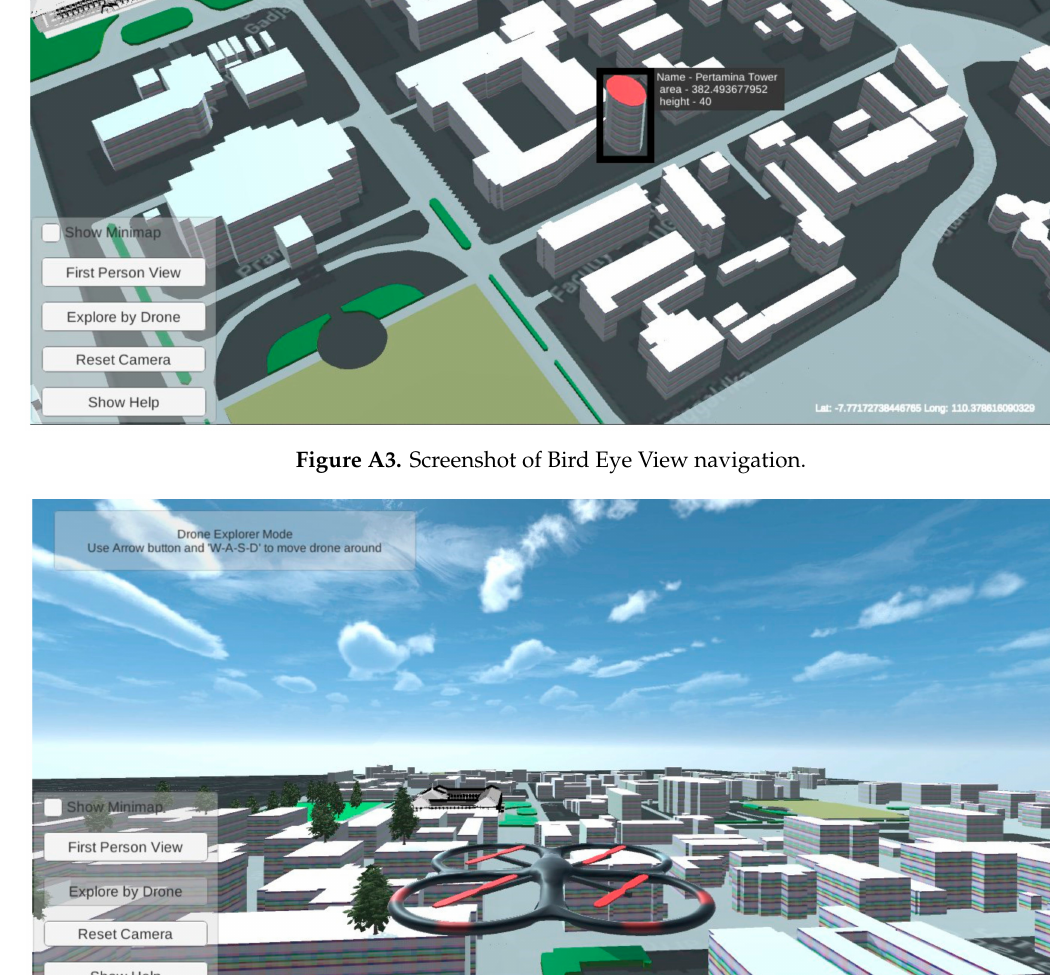
Figure A4. Screenshot of Drone View